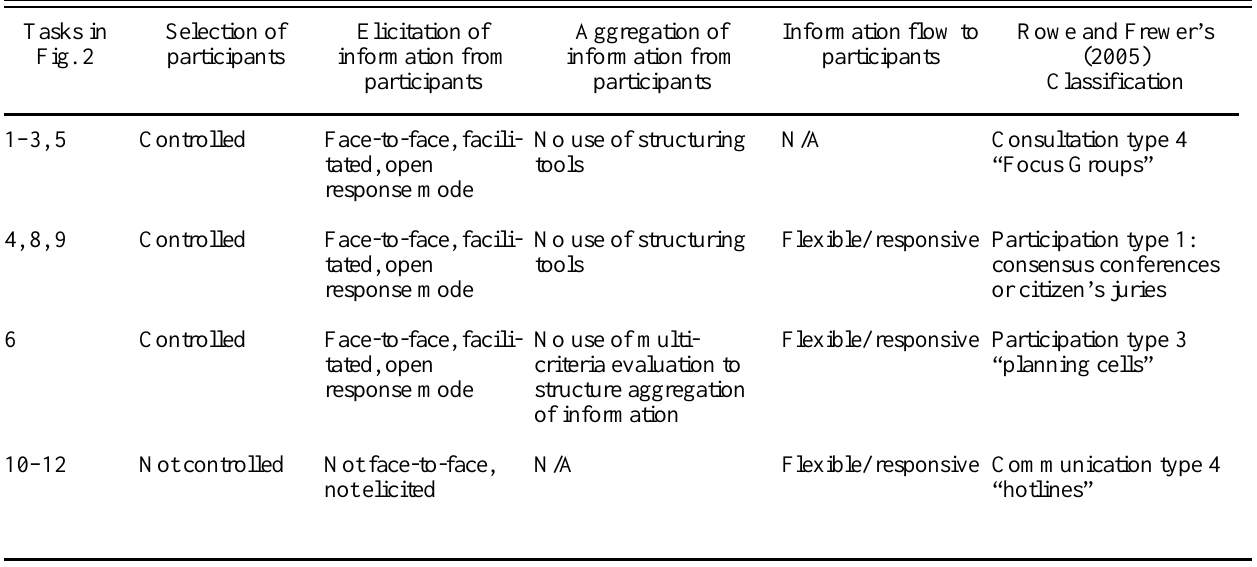
Table 4. Communication and information flow in the Botswana research process (based on Rowe and Frewer’s (2005) classification) Tasks in Selection of Elicitation of Aggregation of Information flow to Rowe and Frewer’s Fig. 2 participants information from information from participants (2005) participants participants Classification 1–3, 5 Controlled Face-to-face, facili No use of structuring N/A Consultation type 4 tated, open tools “Focus Groups” response mode 4, 8, 9 Controlled Face-to-face, facili No use of structuring Flexible/ responsive Participation type 1: tated, open tools consensus conferences response mode or citizen’s juries Controlled Face-to-face, facili No use of multi- tated, open criteria evaluation to response mode structure aggregation of